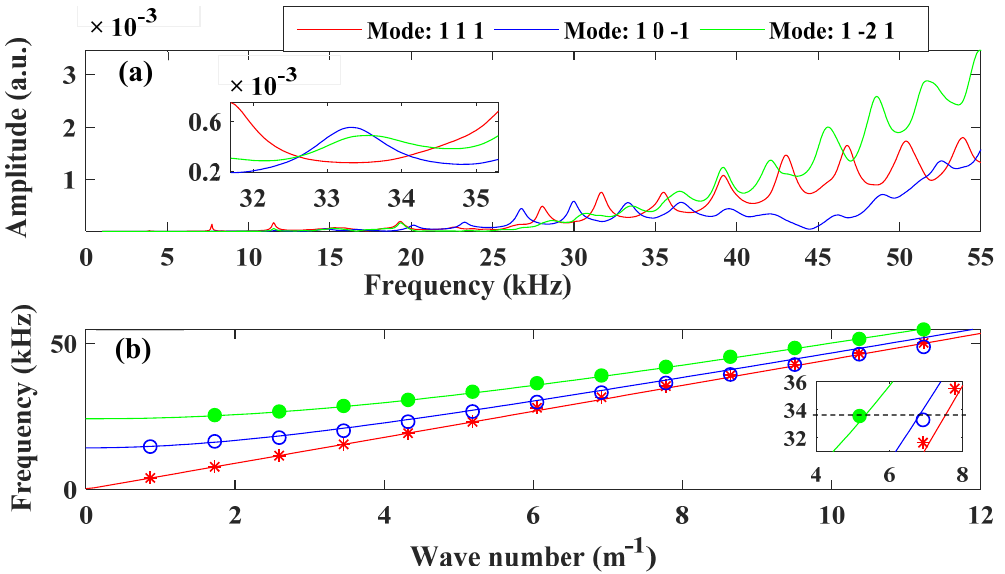
Figure 5. ( a ) Transmission spectrum of the coupled three-rod waveguides ( N = 3 ) for the three spatial eigen modes of (1 1 1), (1 0 − 1), and (1 − 2 1). The transmission amplitude is in arbitrary units. ( b ) Band structure determined and calculated from ( a ). The asterisks in ( b ) are obtained from the resonances of ( a ), and the solid line associated with the asterisks is a fit to the low frequency resonances. The open and solid circles in ( b ) correspond to resonant modes associated with the e 2 and e 3 spatial eigen modes. The solid lines are a fit to the identifiable resonances using the dispersion relations with cutoff frequencies 14.23 kHz for e 2 and 24.27 kHz for e 3 . The inset on ( a ) and the dashed line in the inset of ( b ) focus on a frequency interval showing nearly overlapping (1 0 − 1) and (1 − 2 1) resonances and a trough between two resonances in the (1 1 1) transmission around 33.25 kHz.